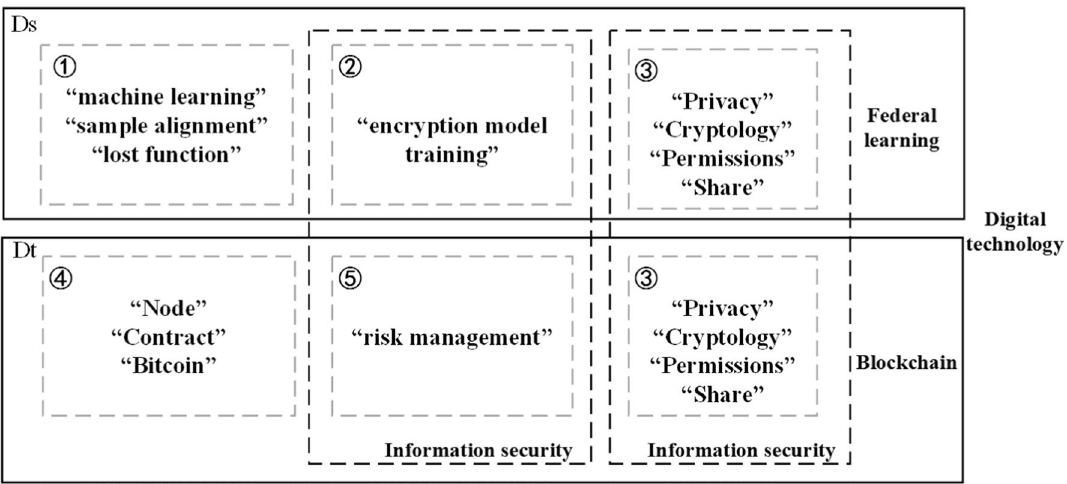
Fig. 1 Example of text classification transfer learning task (federated learning is the field to which the data in D s belong; Blockchain is the field to which the data in D t belong; Information security and Digital technology are potential themes extracted from the raw